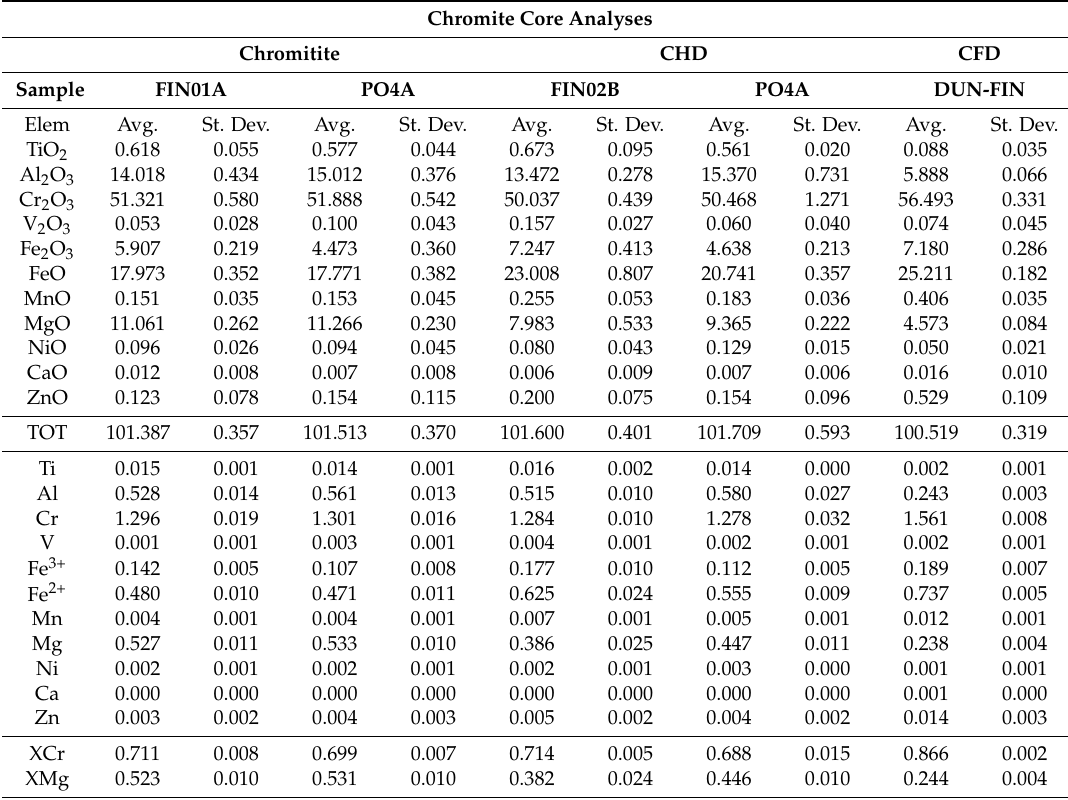
Table 1. Major and trace elements average composition and standard deviation of chromite cores from Rio Creves and Alpe Polunia, for the three host rocks: chromitite, CHD and CFD. XCr [=Cr/(Cr + Al)]. XMg [=(Mg/(Mg + Fe 2+